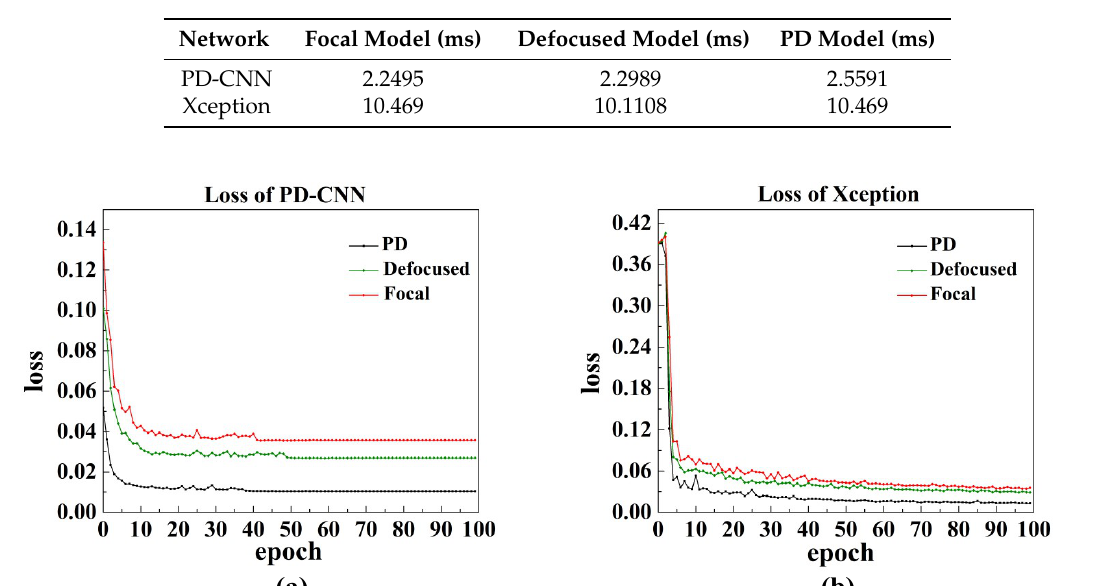
Table 3. The inference time(ms) of PD-CNN and Xception on 1080Ti.